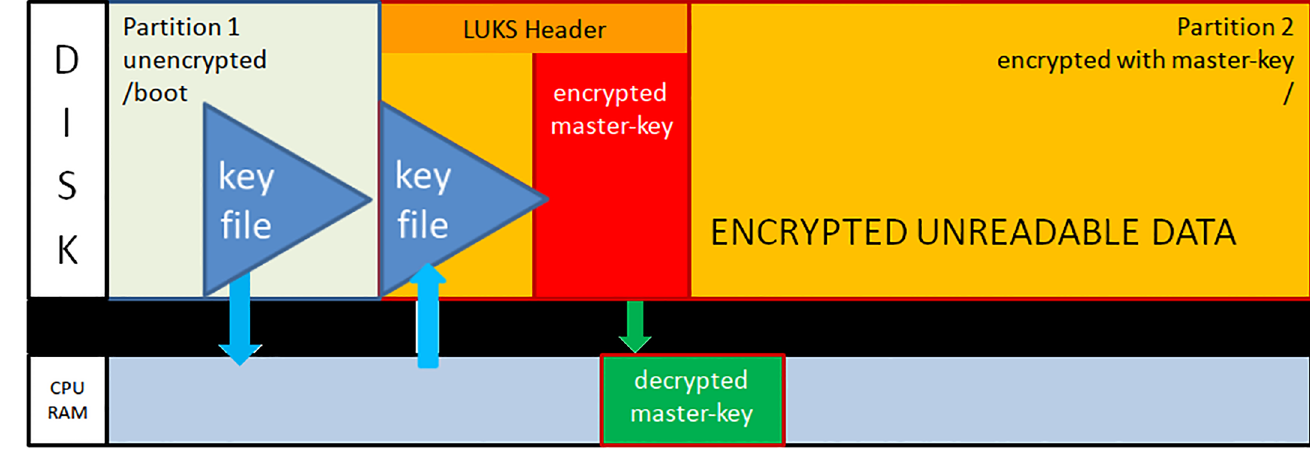
Fig 2. The master-key is decrypted using the passphrase and stored in volatile